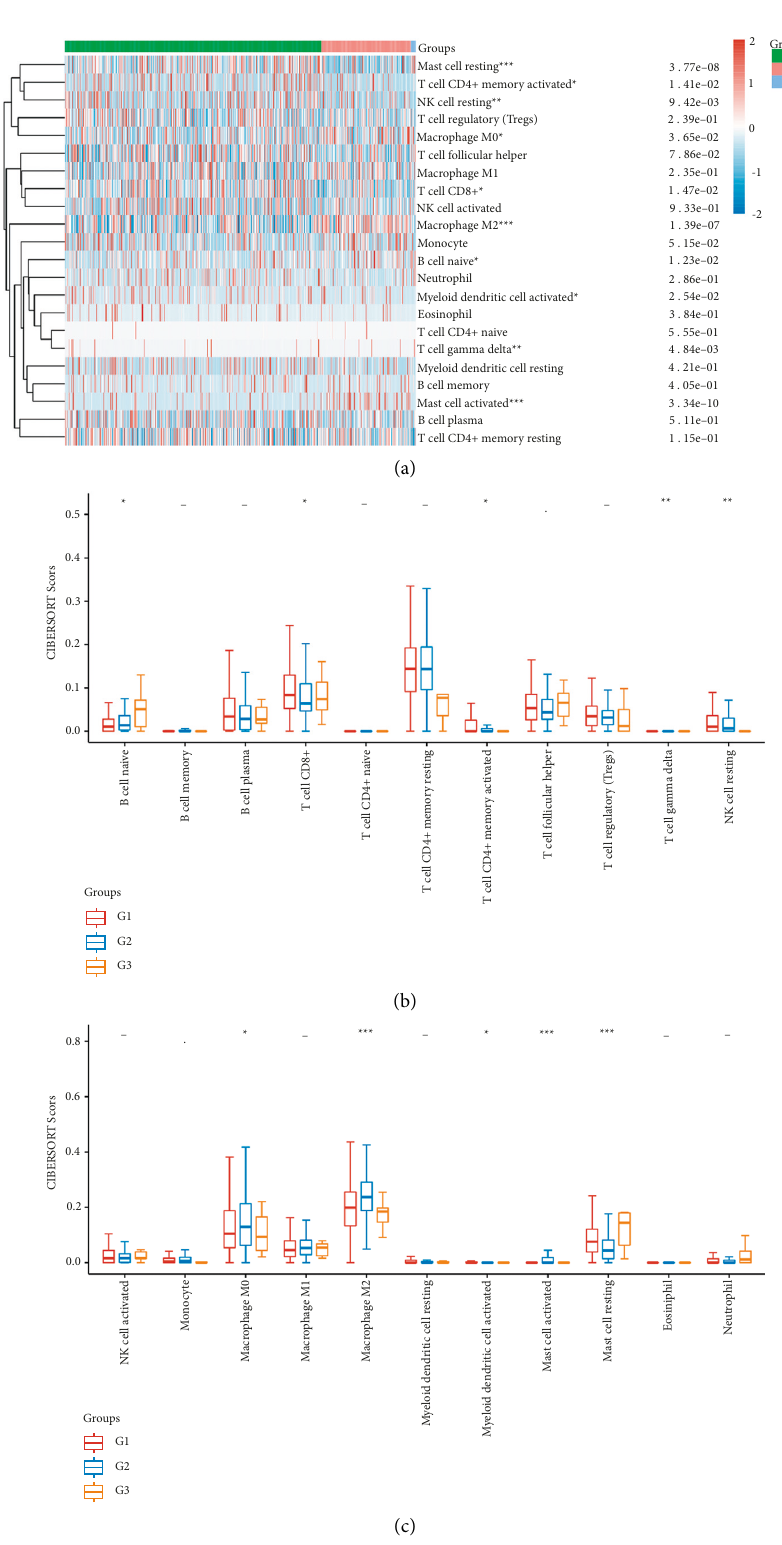
Figure 6: Association between immune infiltration and genomic consensus cluster in CRC. (a) Heatmap analysis showing immune infiltration of immune cells in three subgroups by the CIBERSORTalgorithm. (b) Box-plot analysis showing immune infiltration levels in three subgroups by the CIBERSORT